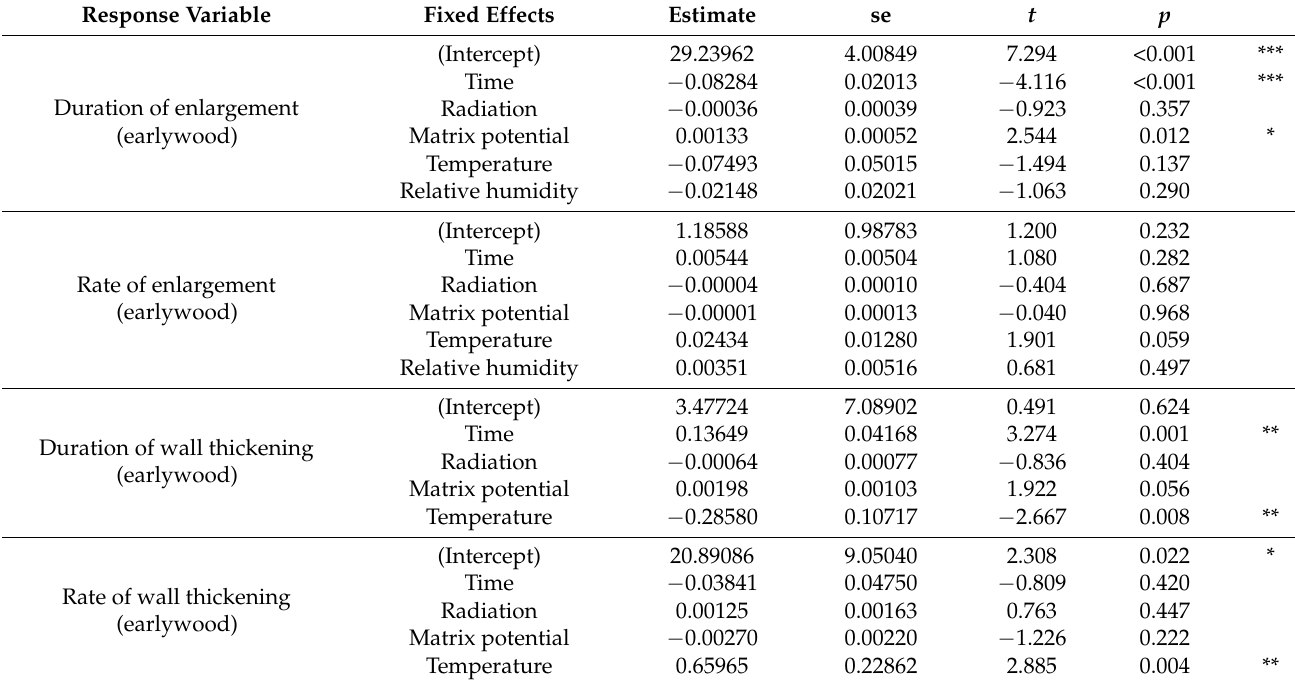
Table 2. Parameter estimates, standard errors, t -statistics, and p -values of fixed effects of linear mixed-effects models to predict the duration of cell enlargement, rate of cell enlargement, duration of cell wall thickening, and rate of cell wall thickening of earlywood